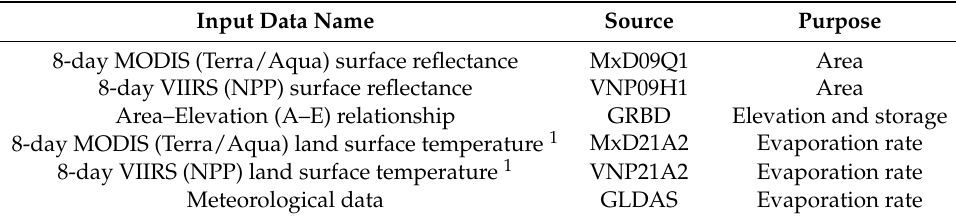
Table 3. Summary of the input data names, sources, and purposes used in this product.